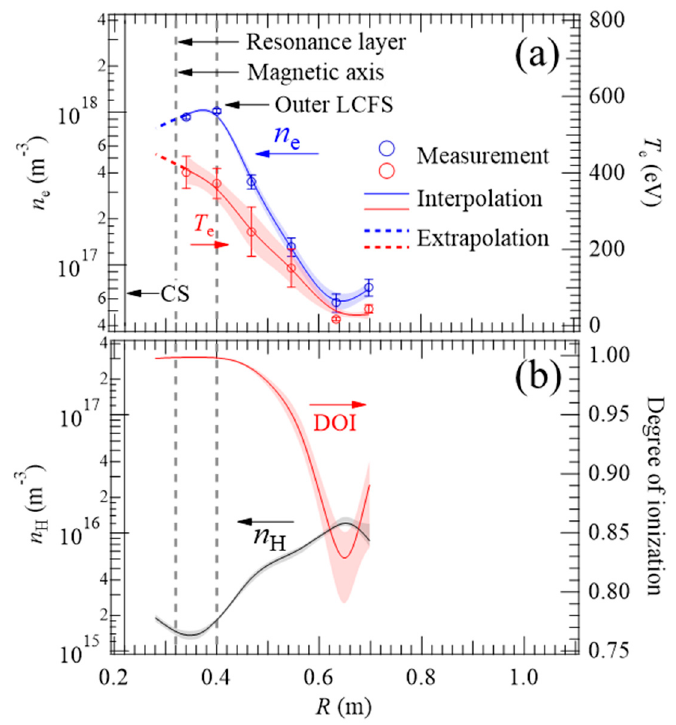
Figure 5. ( a ) T e and n e measured by Thomson scattering and their interpolated and extrapolated Figure 5. ( a ) 𝑇 (cid:2915) and 𝑛 (cid:2915) measured by Thomson scattering and their interpolated and extrapolated curves. ( b ) Evaluated n H and the degree of ionization curves. ( b ) Evaluated 𝑛 (cid:2892) and the degree of ionization (DOI).